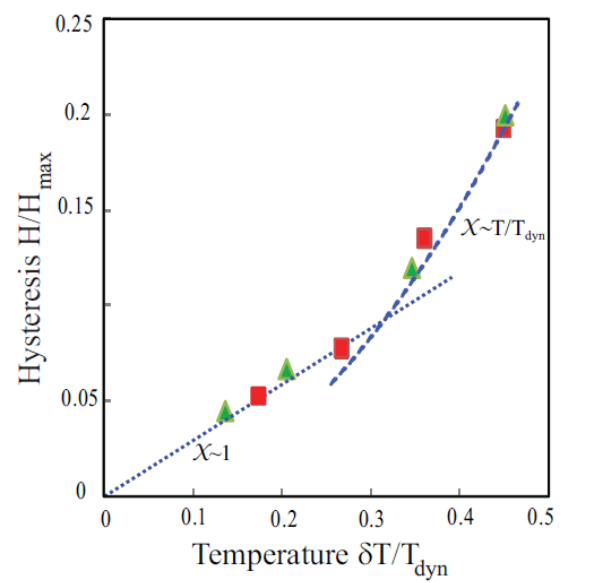
Figure 21. Comparison of the hysteresis observed for the frustrated sold N 2 -Ar mixtures and solid O 2 as a function of the temperature swing of the hysteresis. H max is the maximum variation of the hysteresis. Reproduced with permission from [23]. Copyright Institute of Physics,